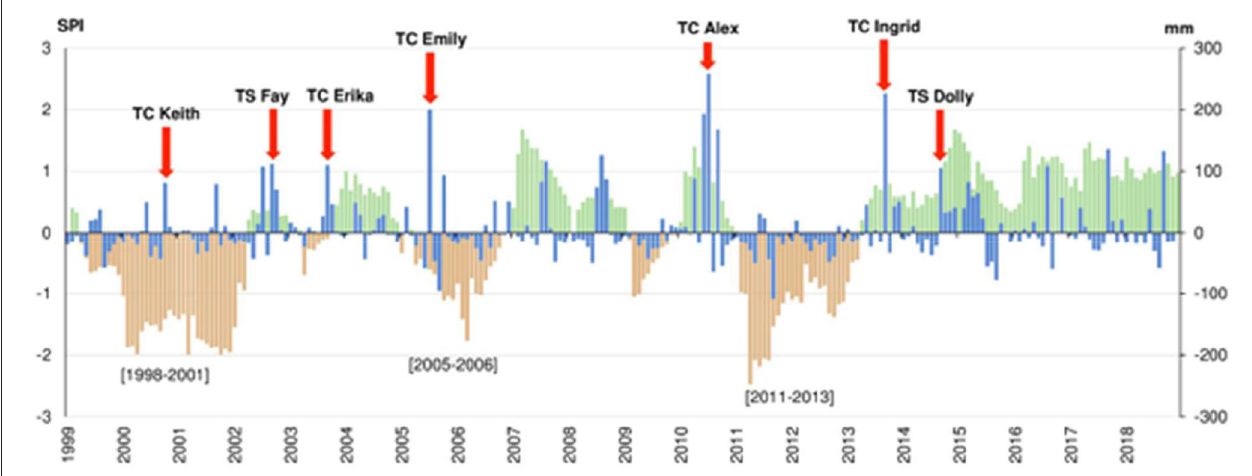
FIGURE 3 | Precipitation anomalies (blue columns) and SPI-12 (green and brown columns) of the MMA. Red arrows correspond to the month when a landfalling TC affected NE Mexico. Numbers in brackets indicate a period of prolonged and severe drought.